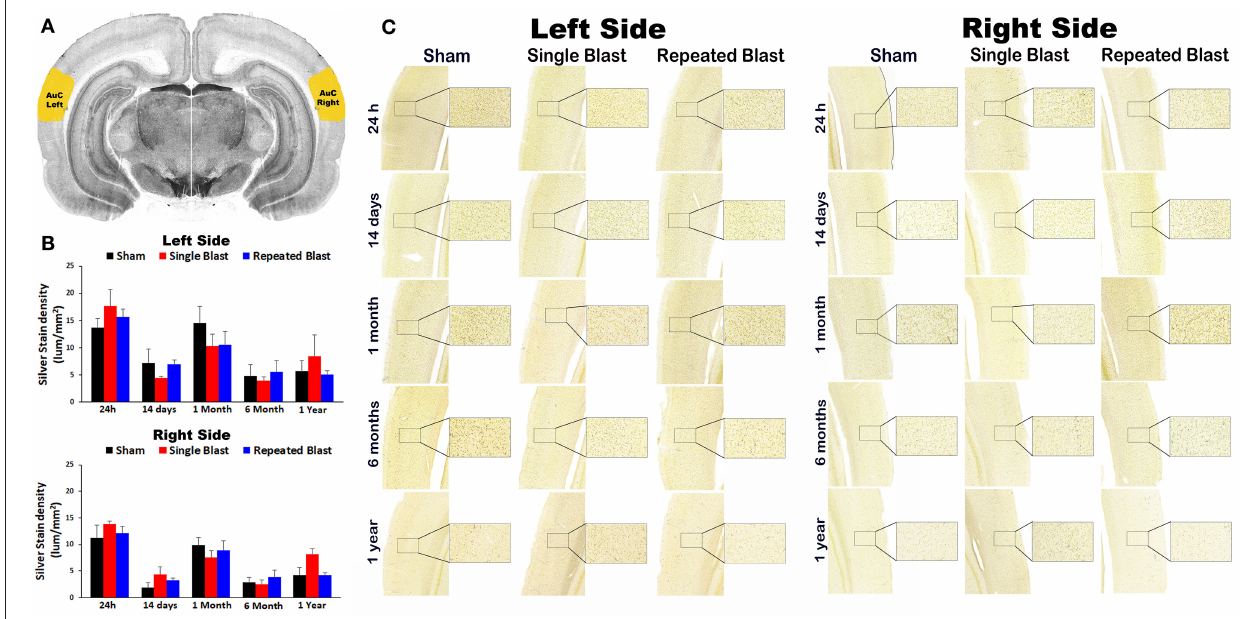
FIGURE 1 | Silver staining in the left and right auditory cortex. (A) The auditory cortex (AuC) region selected using the rat brain atlas for analysis. (B) Graphics showing densitometry analysis from the left and right silver-stained AuC regions at different intervals post-blast exposures. (C) Representative silver-stained images from the left and right AuC regions at different intervals after single and tightly coupled repeated blasts. Portions of sections inside rectangles are shown at higher magnification on the right. Values are expressed as mean ± SEM. Density values of single and repeated blast-exposed groups were compared to the respective sham controls ( p > 0.05, ANOVA; normal distribution; n =